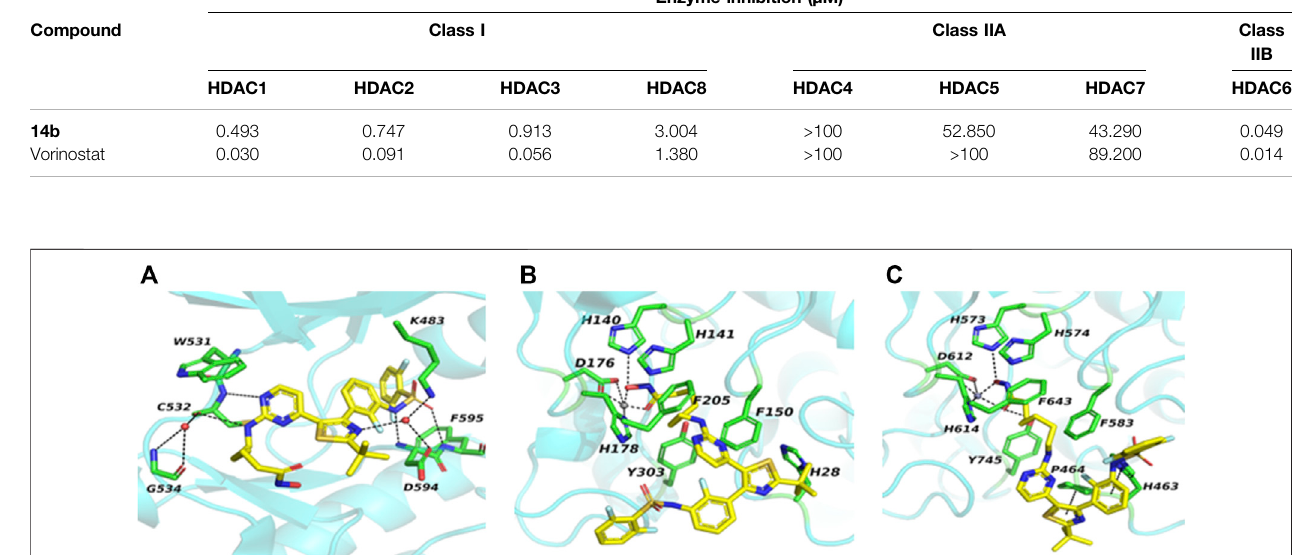
FIGURE2 | Predicted binding mode of 14b into BRAF V600E [ (A) , PDB code: 4xv2], HDAC1[ (B) , PDB code: 4bkx] and HDAC6 [ (C) , PDB code:5eei].The targeted proteins are shown in the turquoise picture with selected residues in stick and carbon atoms in green. Water molecules and metal zinc are shown as red and gray spheres,